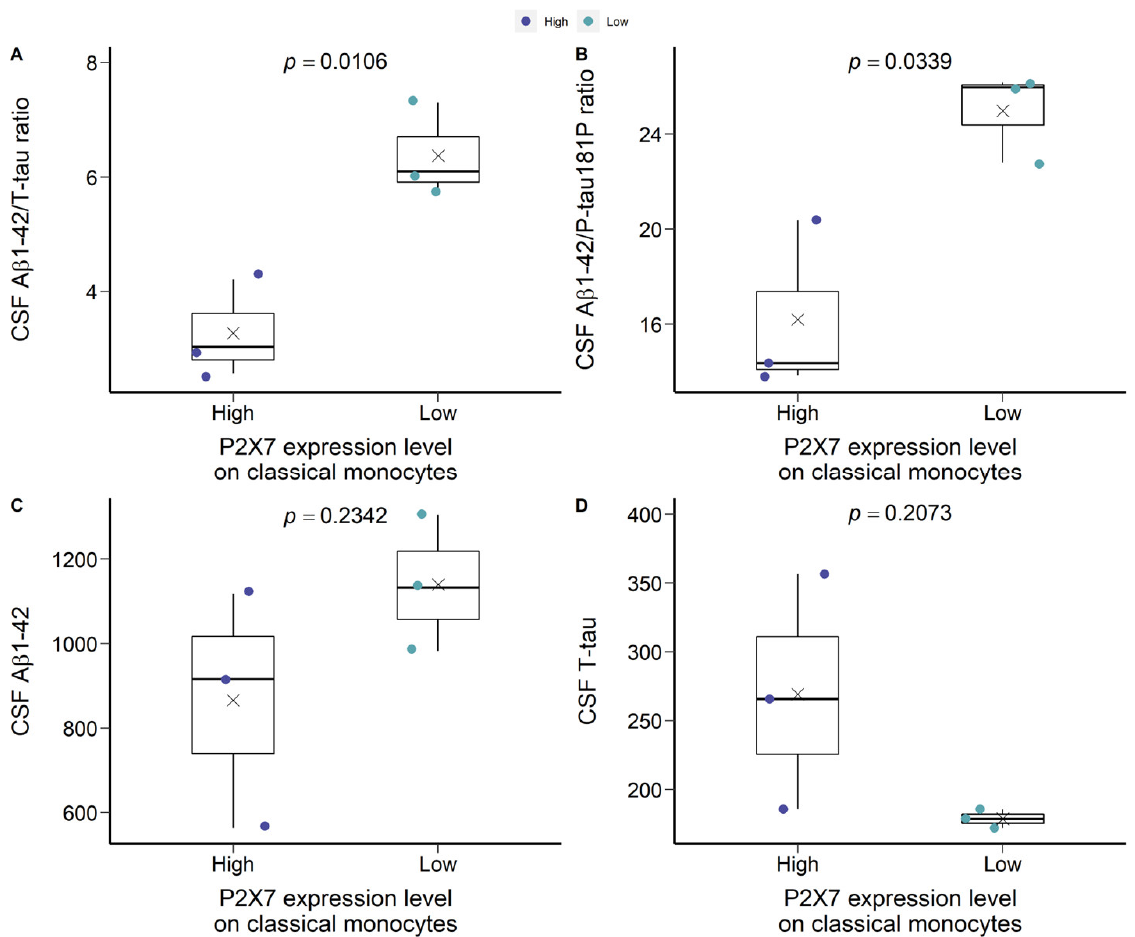
Figure 2. Characteristics of P2X7-low CN −ve and P2X7-high CN −ve groups in the discovery cohort. ( A ) CSF Aβ 1-42 /T-tau ratio. ( B ) CSF Aβ 1-42 /P-tau181P ratio. ( C ) CSF Aβ 1-42 concentration (μg/L). ( D ) CSF T-tau concentration (μg/L). Two group comparison was determined by t -test.